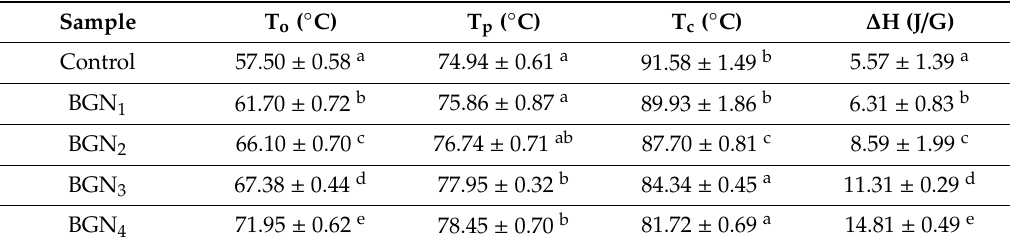
Table 1. Thermal properties of control and maize-Bambara groundnut flour